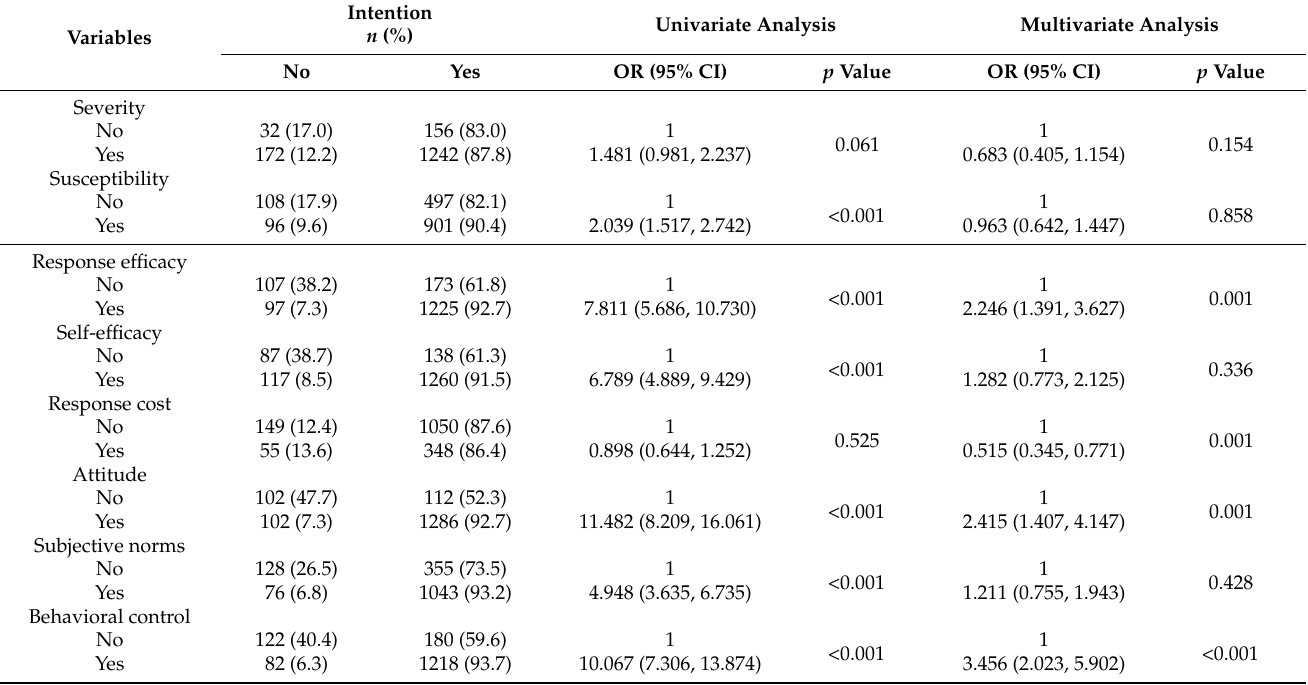
Table 4. Univariate and multivariate analysis of intention and psychological perceptions ( n = 1602).